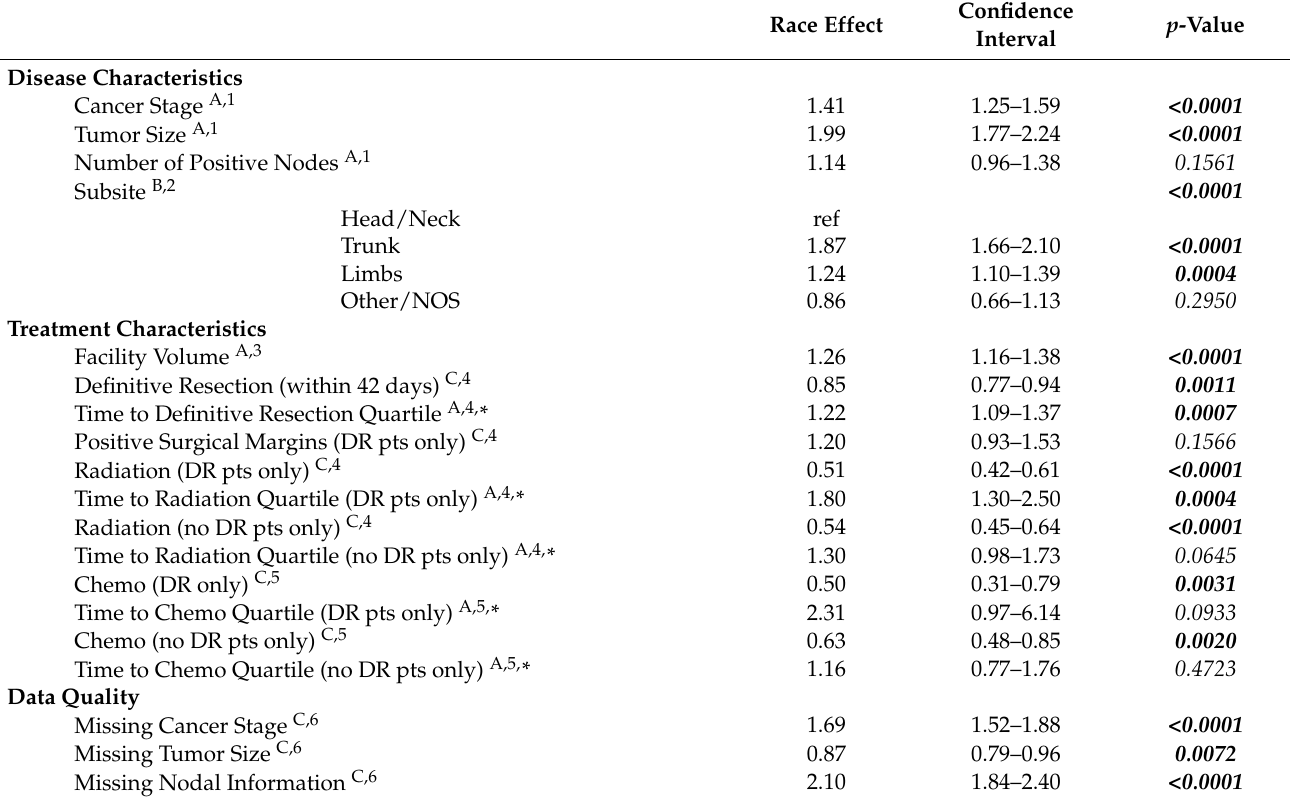
Table 2. Race Effects from Multivariate Modelling of other Clinical